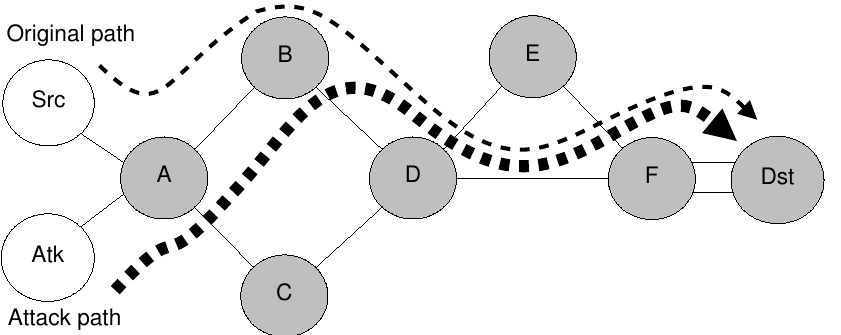
Figure 7. Topology used for MMP evaluation. Dotted curved line shows the user’s communication path and the bold dotted line shows the attacker’s attack